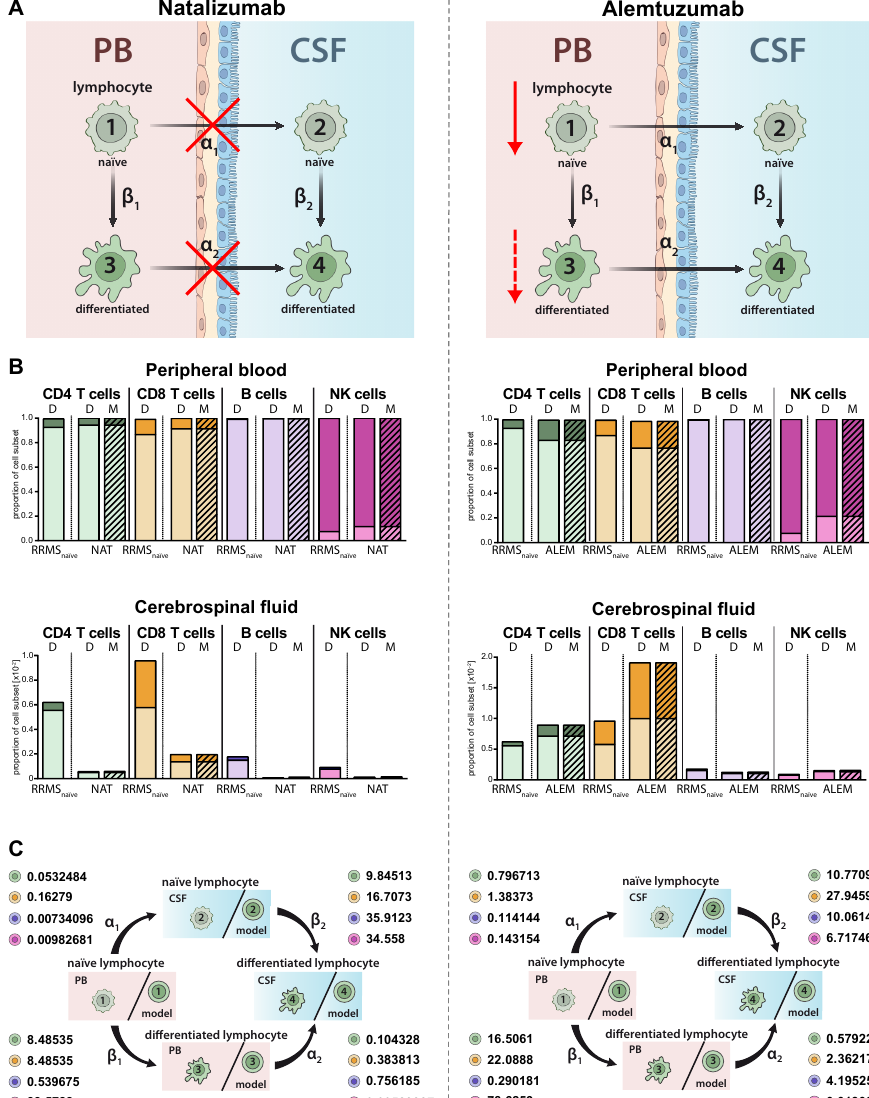
Figure 4. Adjustment of the model to describe alterations in lymphocyte subset transmigration and di ff erentiation in RRMS patients. ( A ) Illustration of the mode of action of the transmigration-blocker natalizumab (left) and lymphocyte-depleting agent alemtuzumab (right). ( B ) Graphs displaying the e ff ect of immune-modulating treatment on RRMS patients ( N = 216) with natalizumab (left, NAT, N = 41) and alemtuzumab (right, ALEM, N = 28). Data (D, Table S1) showing the frequency of naïve (light colors) and di ff erentiated (dark colors) lymphocyte subsets in the PB (top) and CSF (bottom) are compared to values calculated by the model (M, hatched bars). ( C ) Rates (%) determined by the model indicating the transitions from (i) naïve lymphocytes in the PB compartment to the CSF compartment ( α 1 ), (ii) naïve lymphocytes to di ff erentiated lymphocytes within the PB ( β 1 ), (iii) di ff erentiated lymphocytes from the PB to the CSF compartment ( α 2 ), and (iv) naïve lymphocytes to di ff erentiated lymphocytes within the CSF ( β 2 ) in RRMS patients under natalizumab (left) or alemtuzumab (right) treatment are displayed for the respective lymphocyte